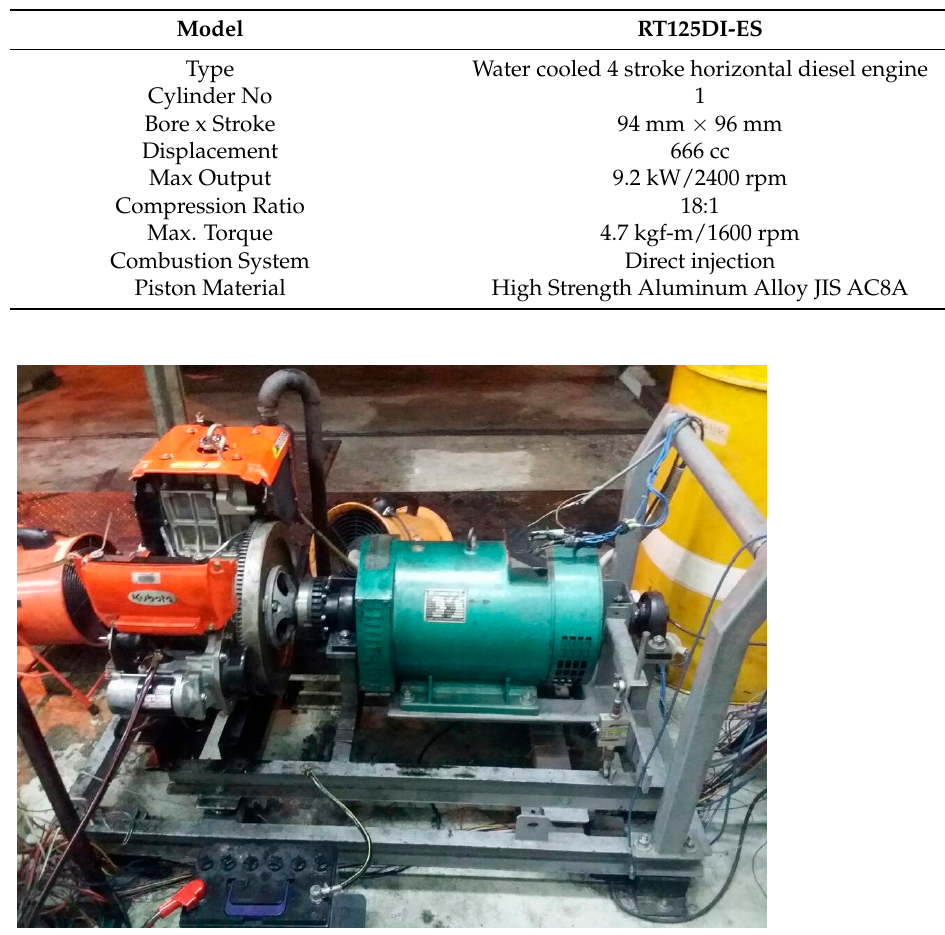
Figure 1. Schematic diagram for the experimental setup. Table 1. Engine Specification.